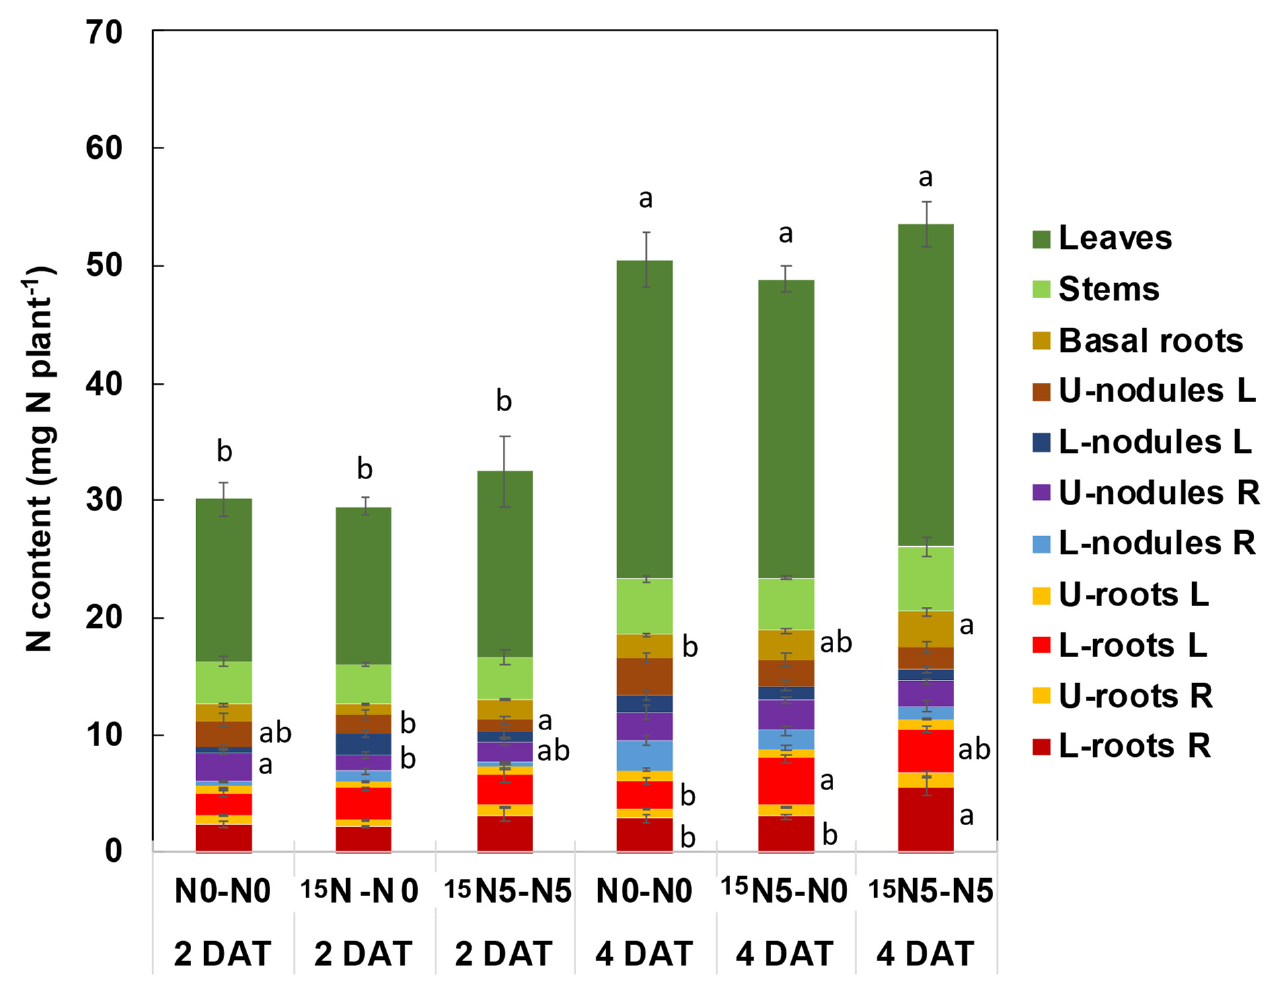
Figure 2. Nitrogen content in each part of soybean plants with after 2 and 4 days of N0-N0, 15 N5-N0, and 15 N5-N5 treatments. Different letters on the top of the columns indicates the significantly different in total N among treatments based on Tukey’s Test ( p < 0.05). Different alphabet at the side of the column indicates the significant difference of N content in the parts among treatments. The letter omitted in the part with no significant difference among three treatments. N = (4). Average ± standard